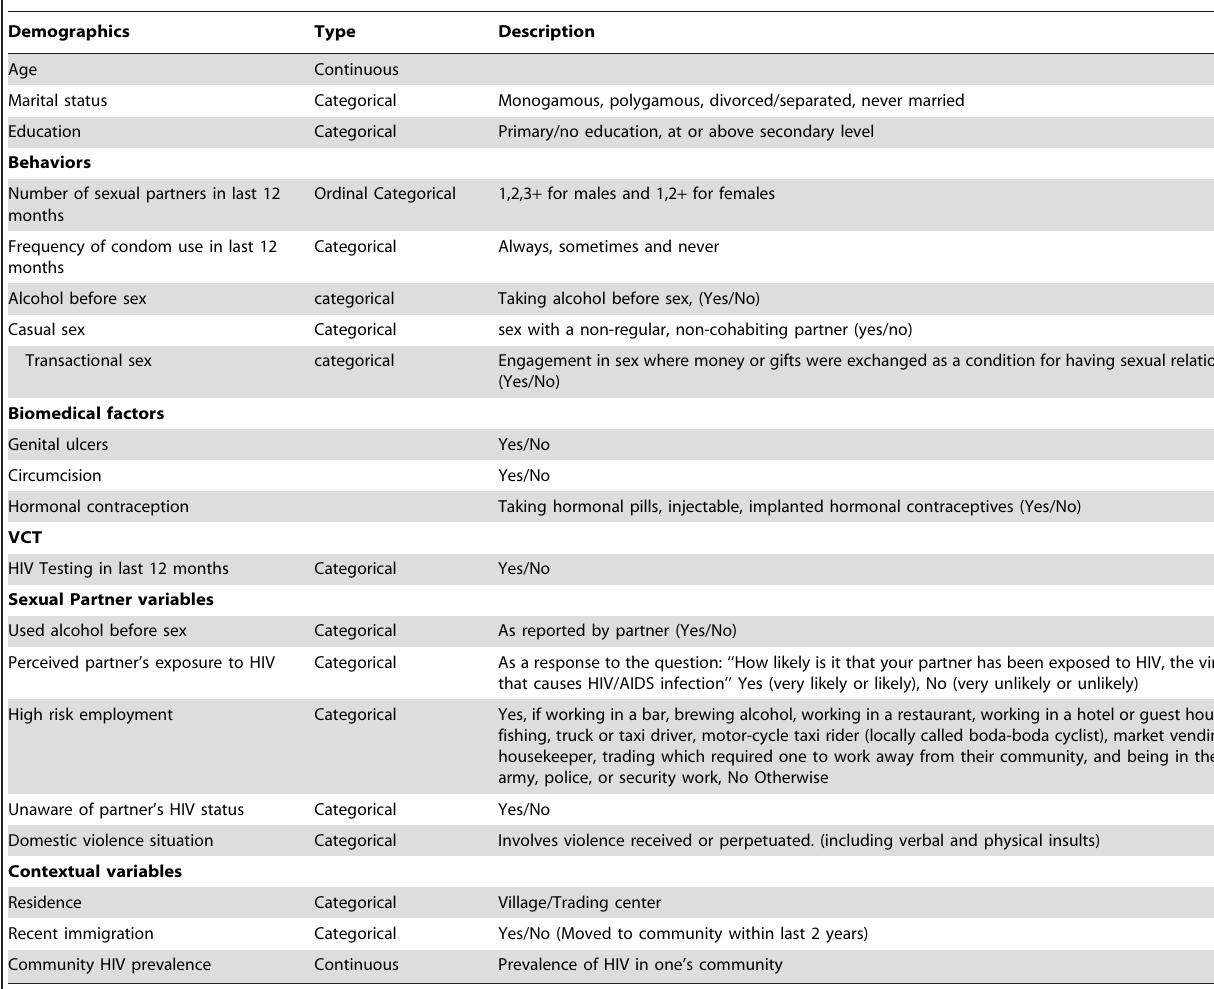
Table 1. Description of potential predictors, Rakai,